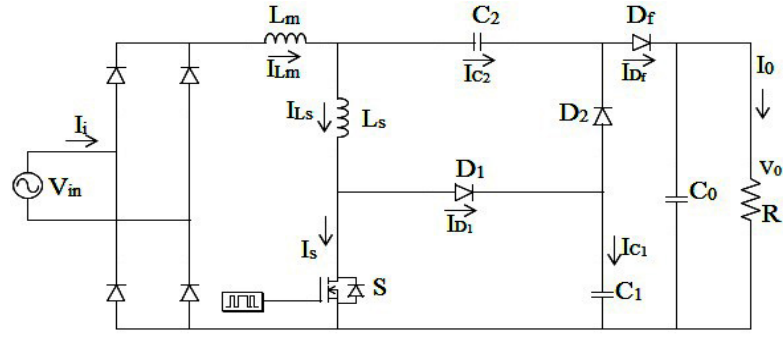
Figure 2. Proposed Boost PFC Converter.